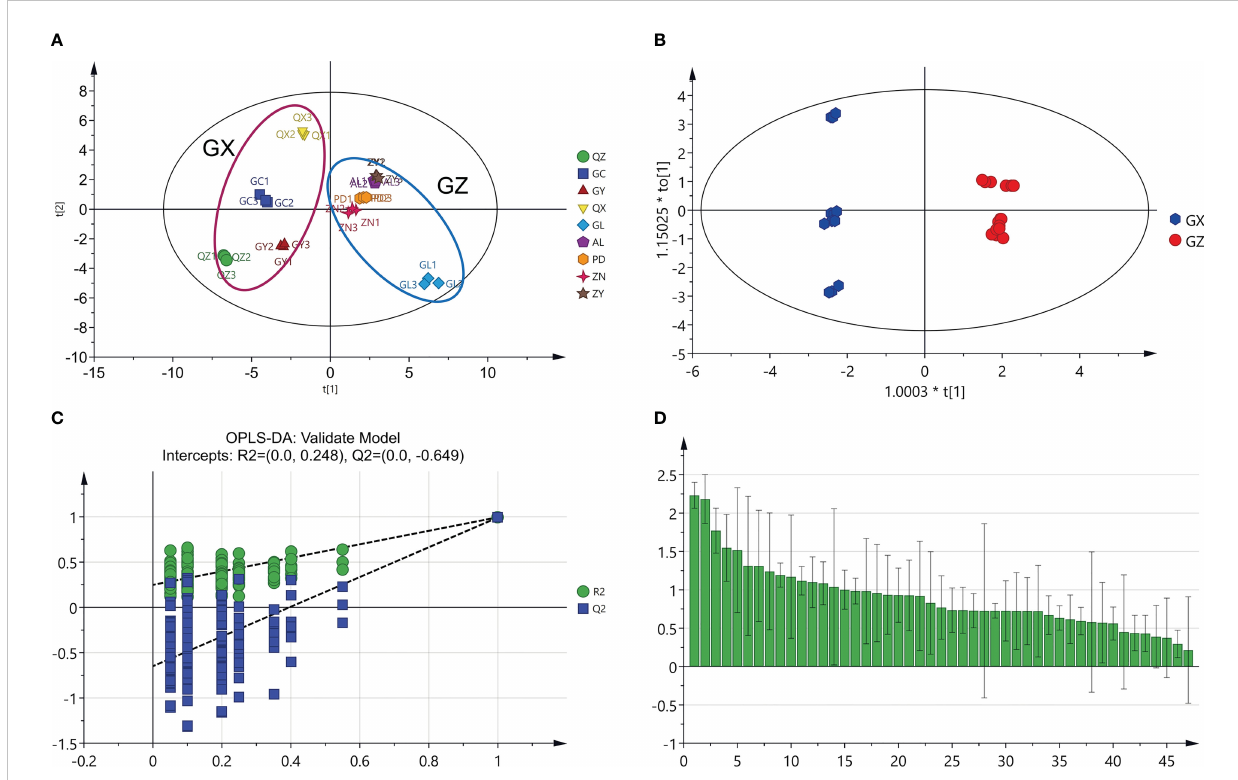
FIGURE 3 Multivariate statistical analysis of two groups of P. petiolosa based on the concentration of 47 common fl avonoids. (A) Principal component analysis (PCA) score plot; (B) Orthogonal partial least square discriminant analysis (OPLS-DA) score plot; (C) results of permutation testing of the OPLS-DA model with 200 repetitions; (D) VIP score plot of the candidate fl avonoids markers for P. petiolosa